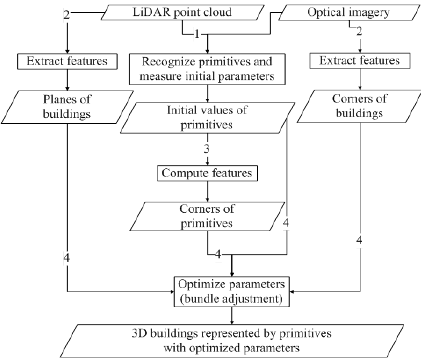
Figure 6: Flowchart of the reconstruction process using LiDAR data and aerial images (Zhang et al.,